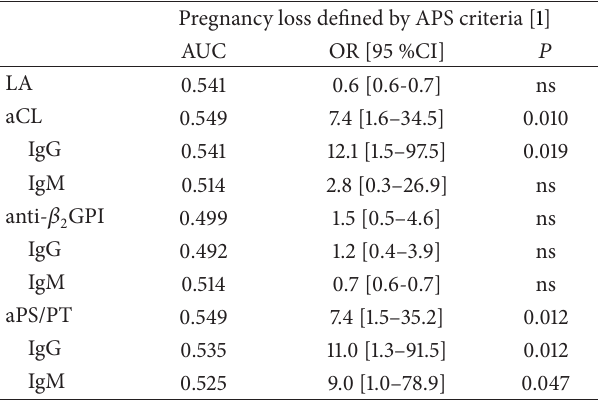
Table 5: Diagnostic accuracy of aPL for pregnancy loss as defined by APS classification